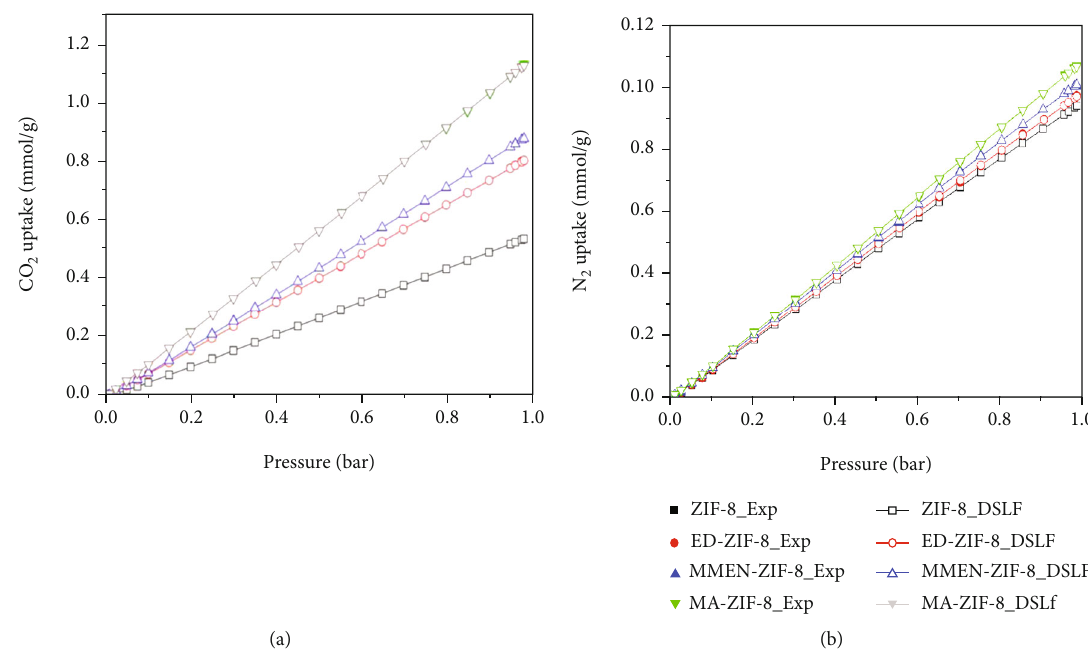
and N isotherms on the amine@ZIF-8 at 298 K: (a) CO 2 2